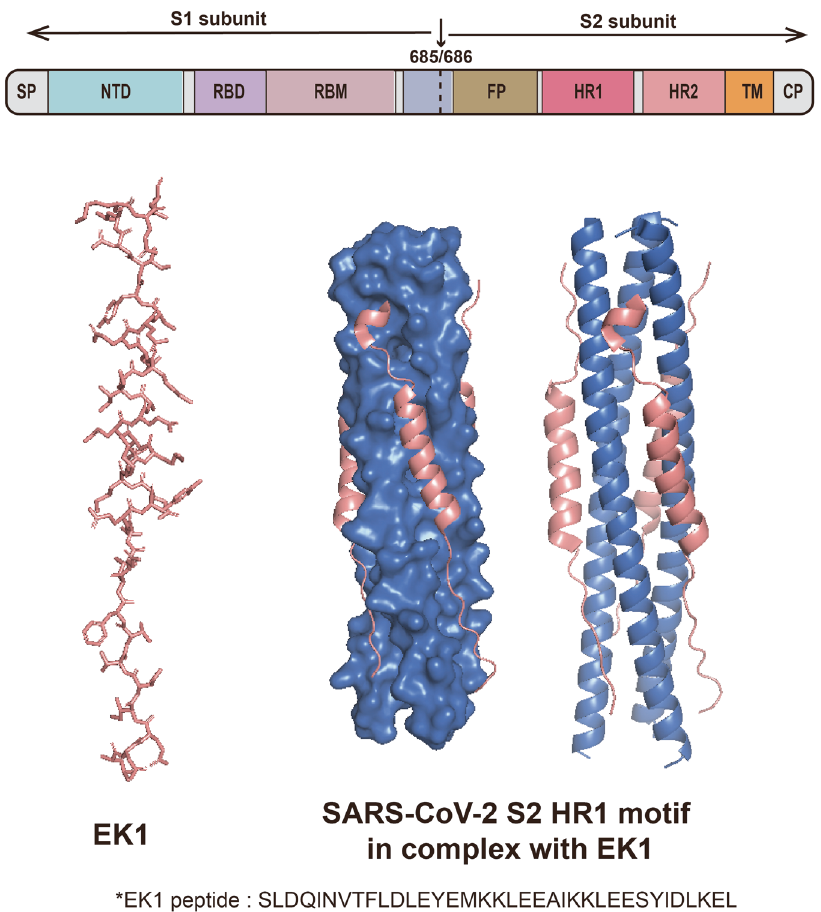
Fig. 6 S2 subunit of SARS-CoV-2 S protein involves the HR1 and HR2 trimers to form a 6-HB domain. The binding model of the EK1 inhibitor in complex with the HR1 motif is presented (Protein Data Bank entry 7C53)